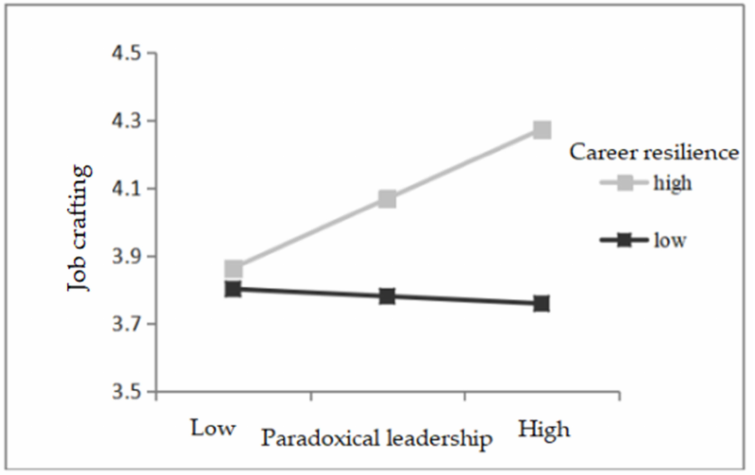
Figure 2. The moderating effect of career resilience between paradoxical leadership and job